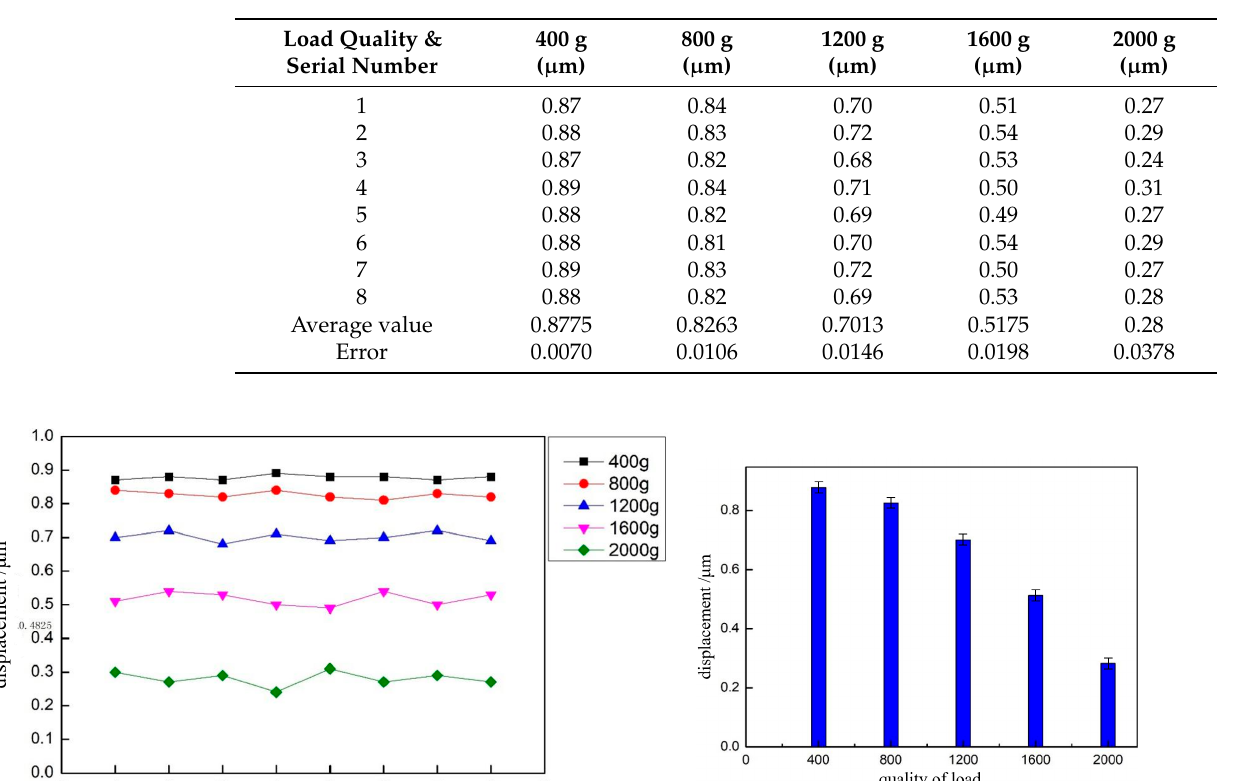
Table 2. Positioning stage output displacement data at different loads.